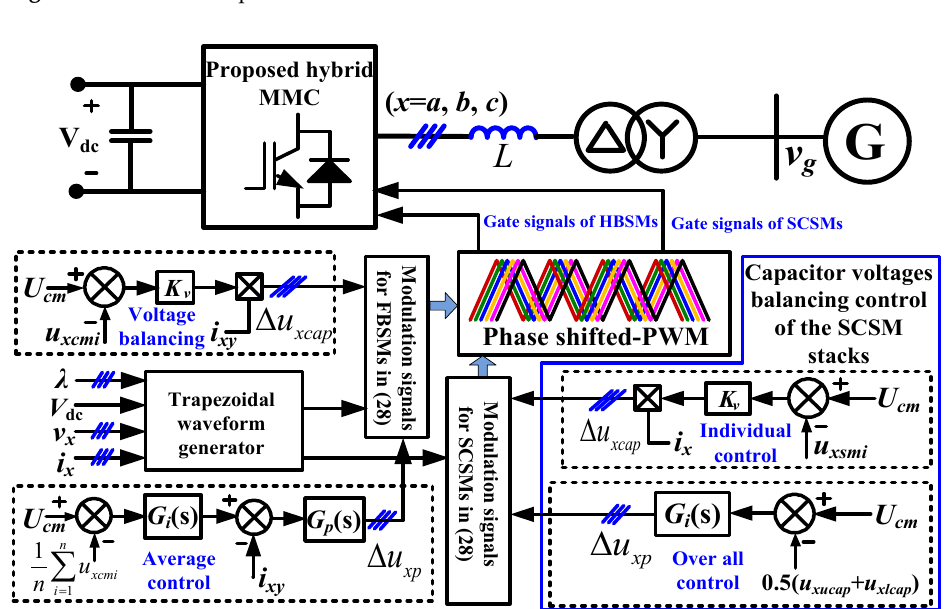
Figure 16. Control diagram of the proposed hybrid MMC.